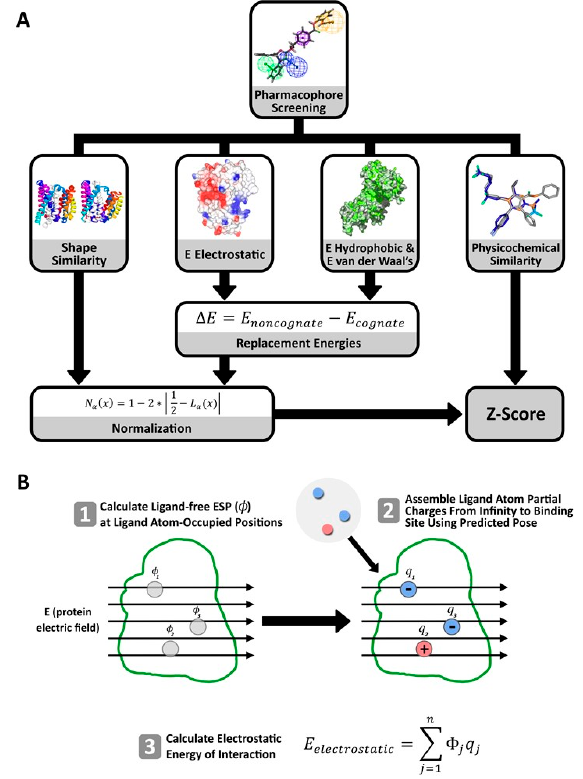
Figure 1. ( A ) Schematic of ES-Screen for predicting ligand-target interactions. ( B ) Process of deter- mining the electrostatic energy of interaction. Using predicted ligand-protein binding poses after pharmacophore screening: (1) ligand-free electrostatic potentials (ESP, Φ ) given by the protein elec- tric field (E) are calculated using Delphi at positions occupied by ligand atoms, (2) ligand atoms, represented as partial charges, are then assembled within the pocket from infinity within solvent of high dielectric constant to ligand-occupied positions within the solute of low dielectric constant, and (3) the electrostatic energy of interaction is calculated using Equation (1).